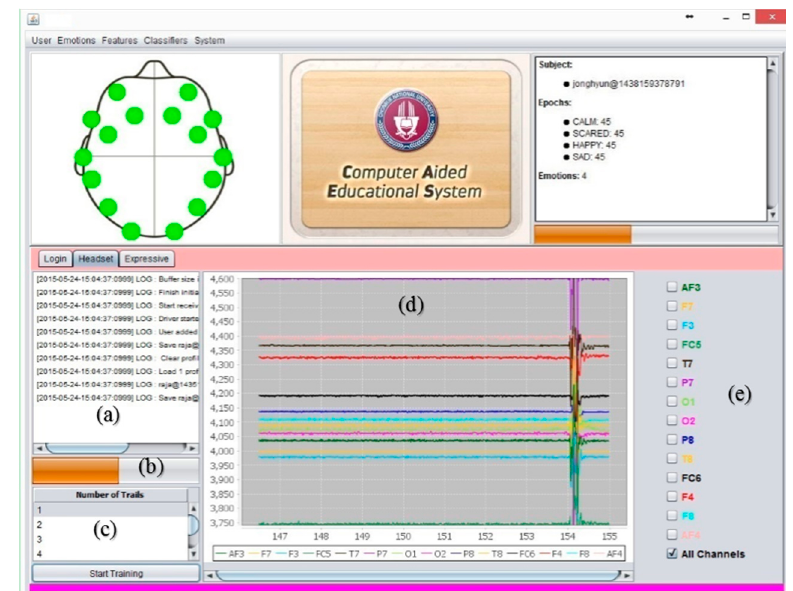
Figure 14. CAES (headset setup); this is also known as the device control module: ( a ) this component shows the device-related events and records into the database; ( b ) is the training progress bar; ( c ) the training component that allows the instructor to record the emotion training of the current subject; this module computes and updates the classification model after each training session; ( d ) this component shows the signal activity of each electrode of the brain device; ( e ) this component helps the user select his/her desired brain electrode.